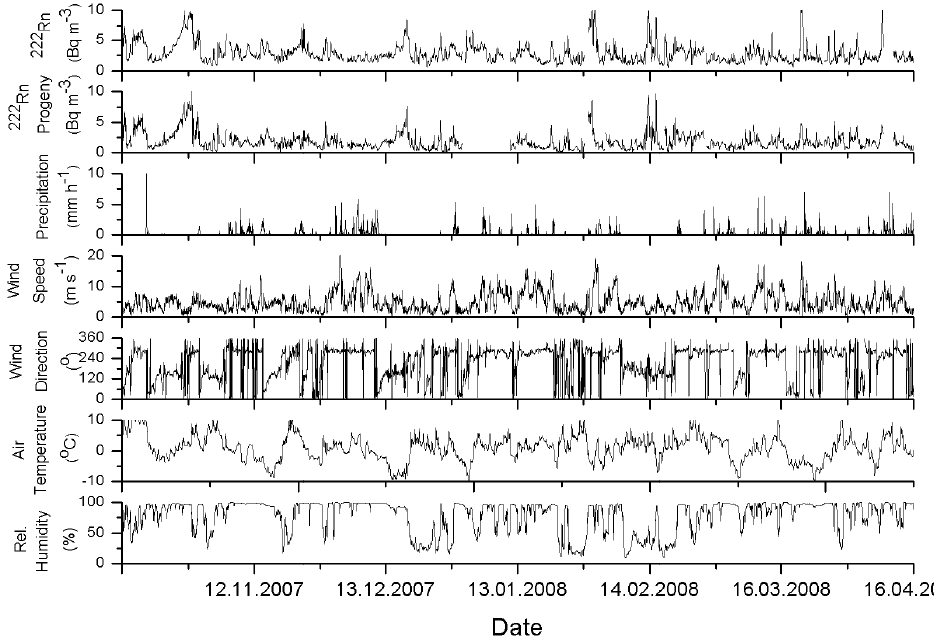
Fig. 3. Time series of hourly means of 222 Rn activity concentration (measured with a two-filter detector) and short-lived 222 Rn progeny, expressed in 222 Rn equivalent (measured with a one-filter detector) before harmonizing background and calibration between instruments, hourly precipitation, mean wind speed, wind direction, air temperature and relative humidity at Schauinsland station from October 2007 to April